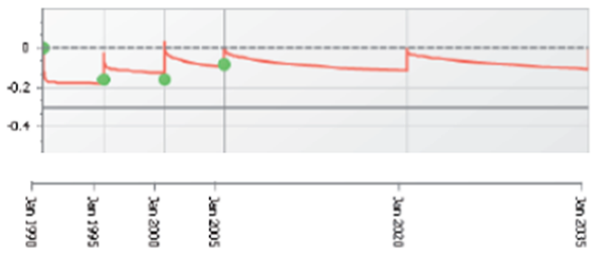
Figure 3. Predicted settlements and (green dots) predicted mainte- nance moments.